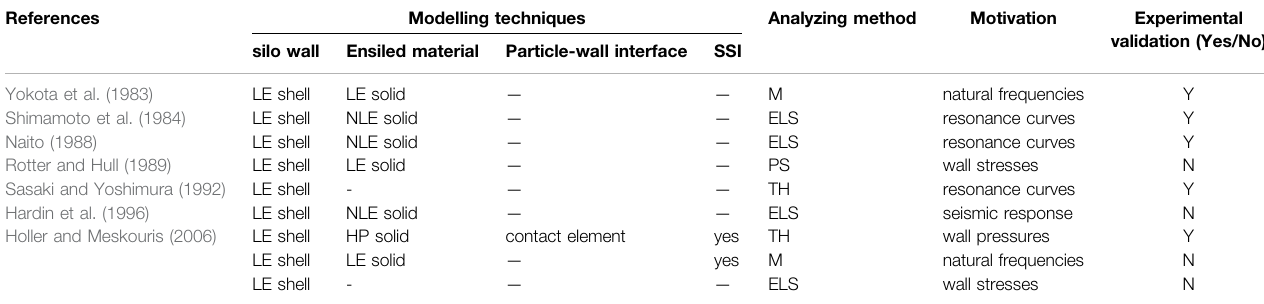
TABLE 3 | Summary of the main characteristics in the cited numerical studies found in scienti fi c